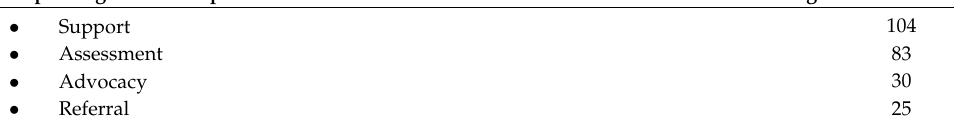
Table 5. Thematic Focus of Included Articles.